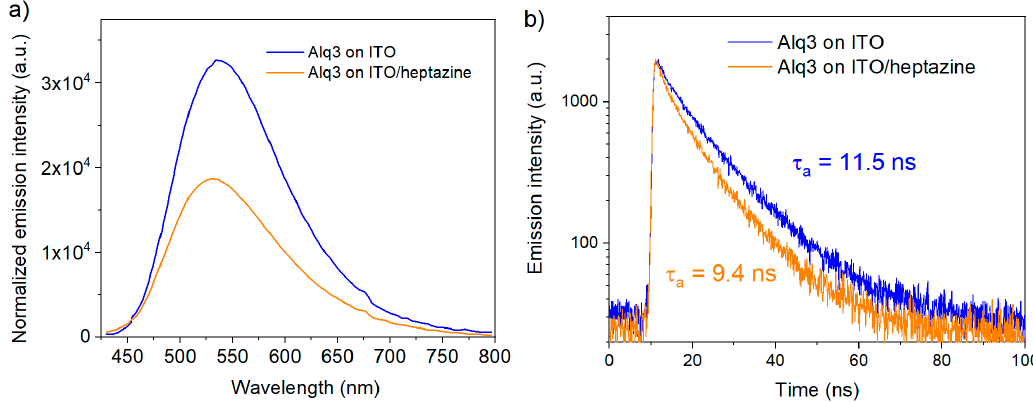
Figure 8. Photoluminescence emission ( a ) and TRPL (time-resolved photoluminescence) decay